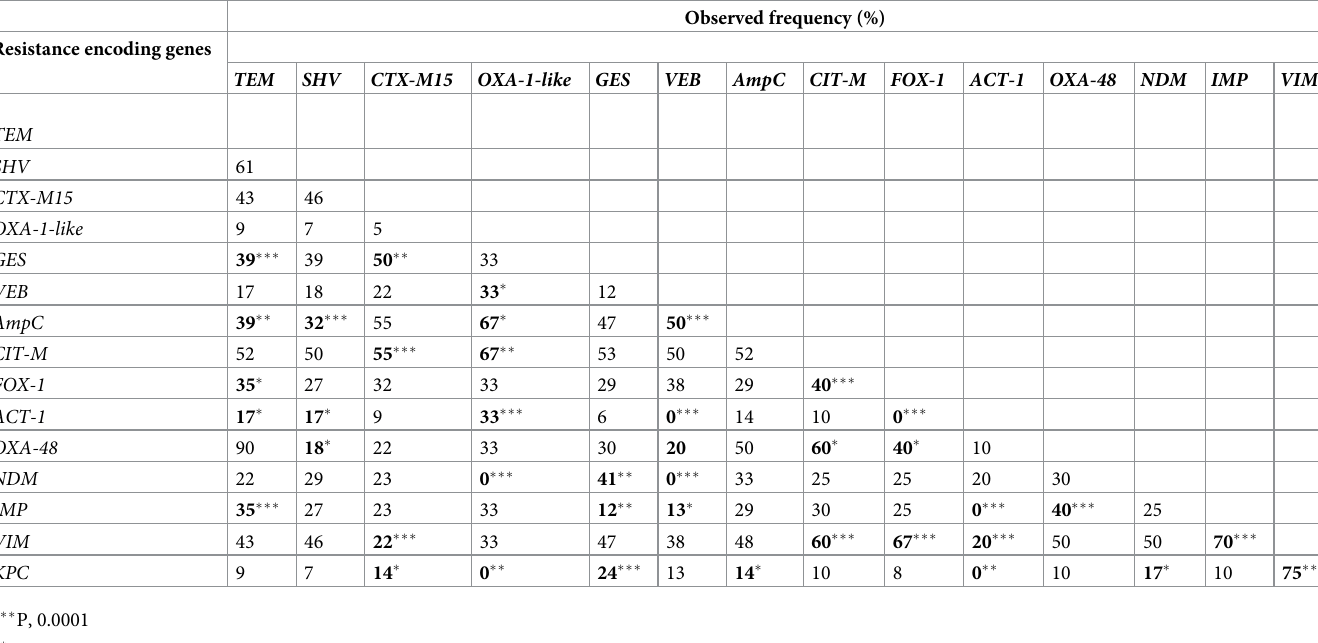
Table 3. Co-detection rates of β -lactam resistance encoding genes amongst 44 K . pneumoniae